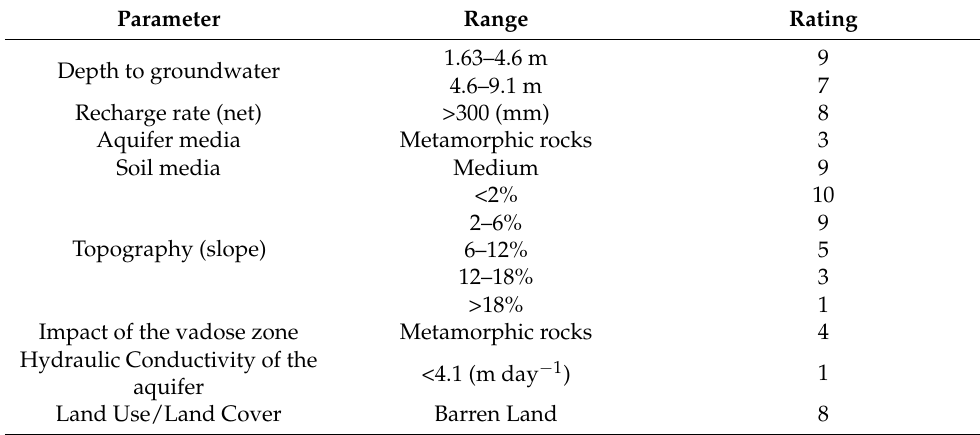
Table 2. DRASTIC-LU parameters. Parameter